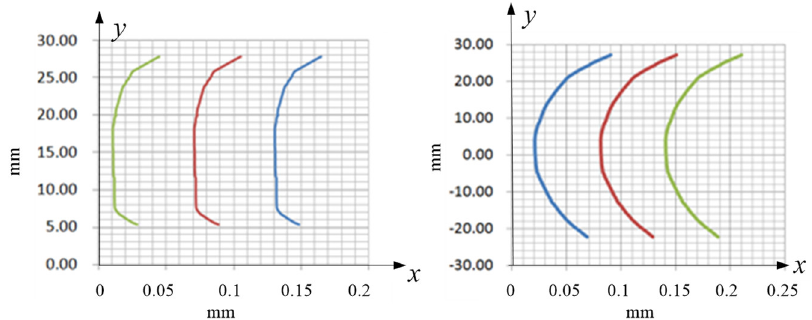
Figure 13. Detection results of the teeth profile modification.